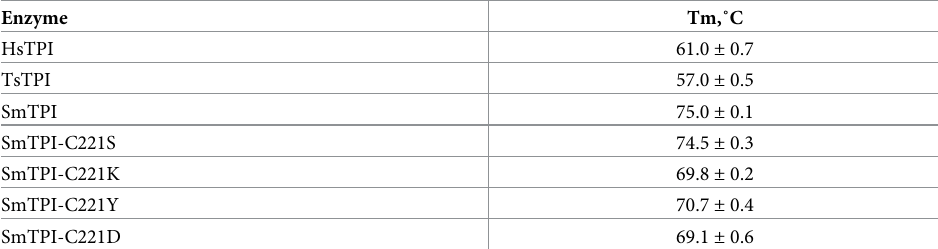
Table 2. Melting temperatures of Wild-type and mutant